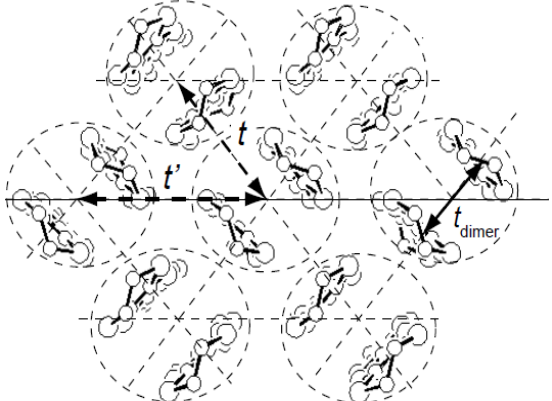
X system. BEDT-TTF 2 dimer